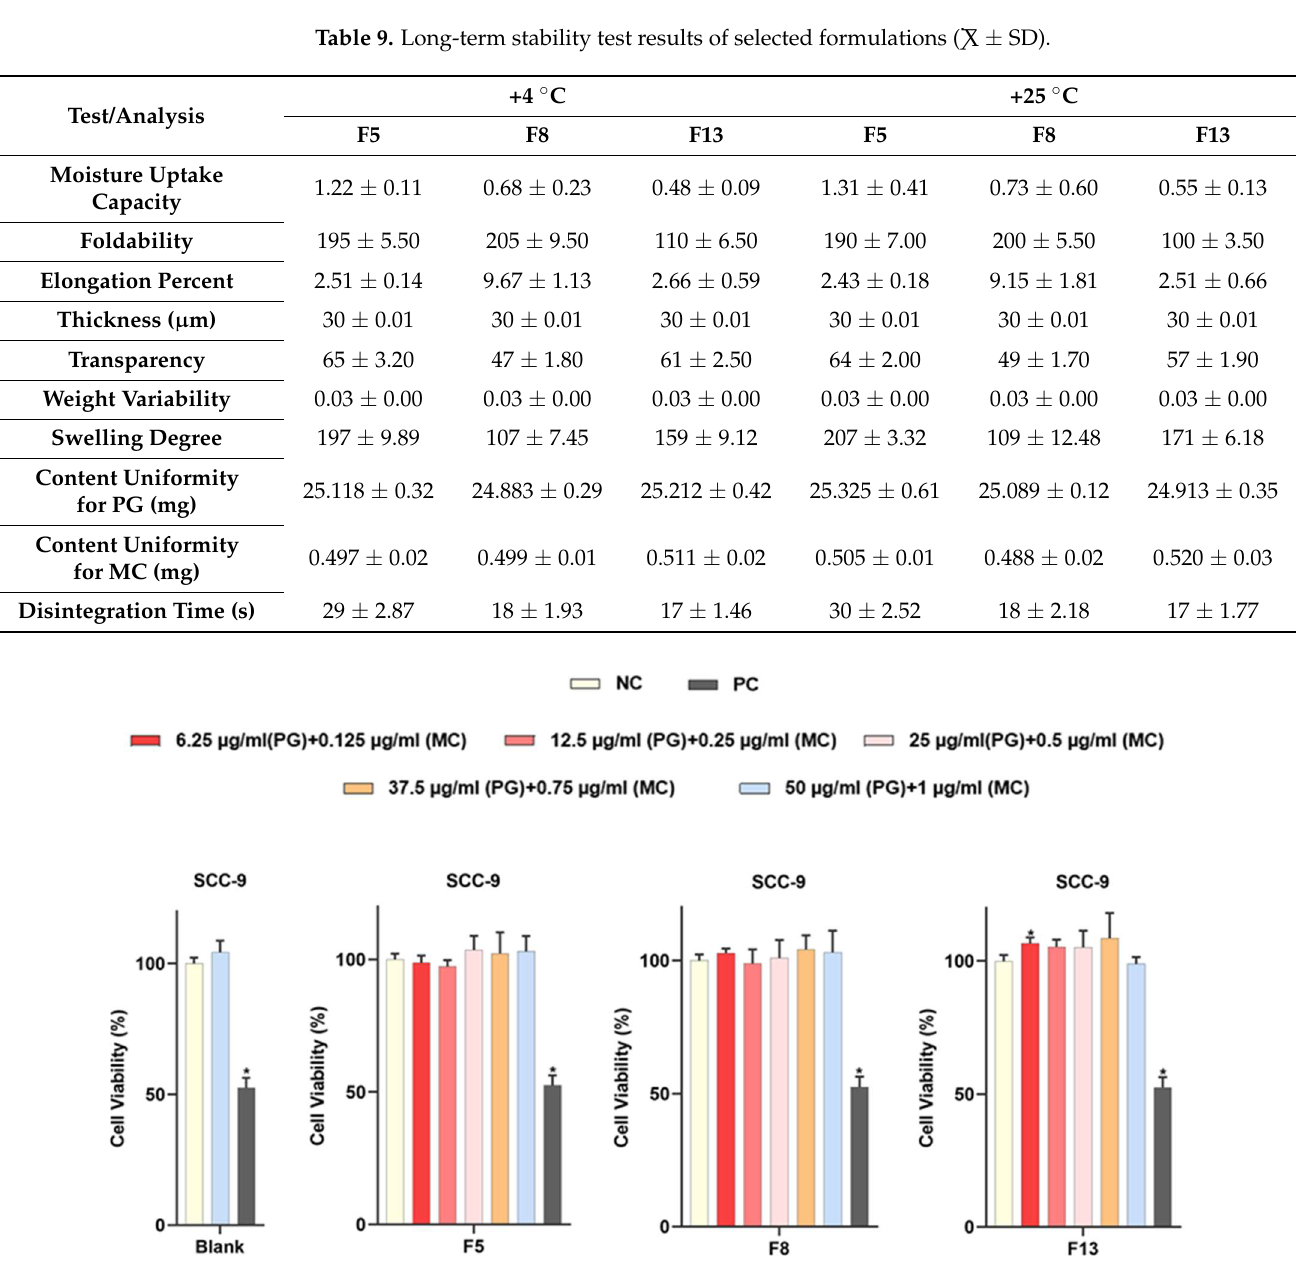
Table 9. Long-term stability test results of selected formulations ( Table 3. PG and MC recovery % data after 72 h ( Ⴟ ± SD).